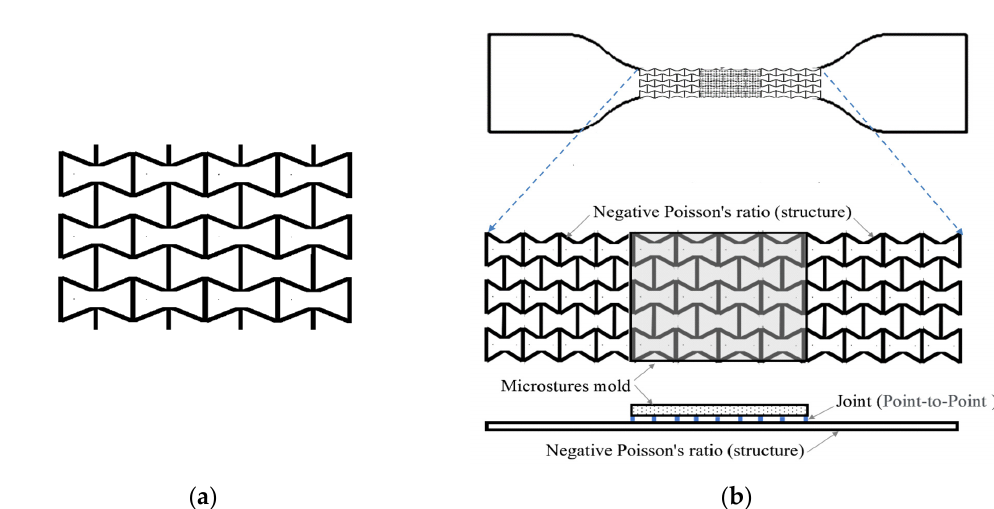
Figure 3. With a flexible NPR structure: ( a ) funnel-shaped and ( b ) microstructure mold-bonding in preparation.